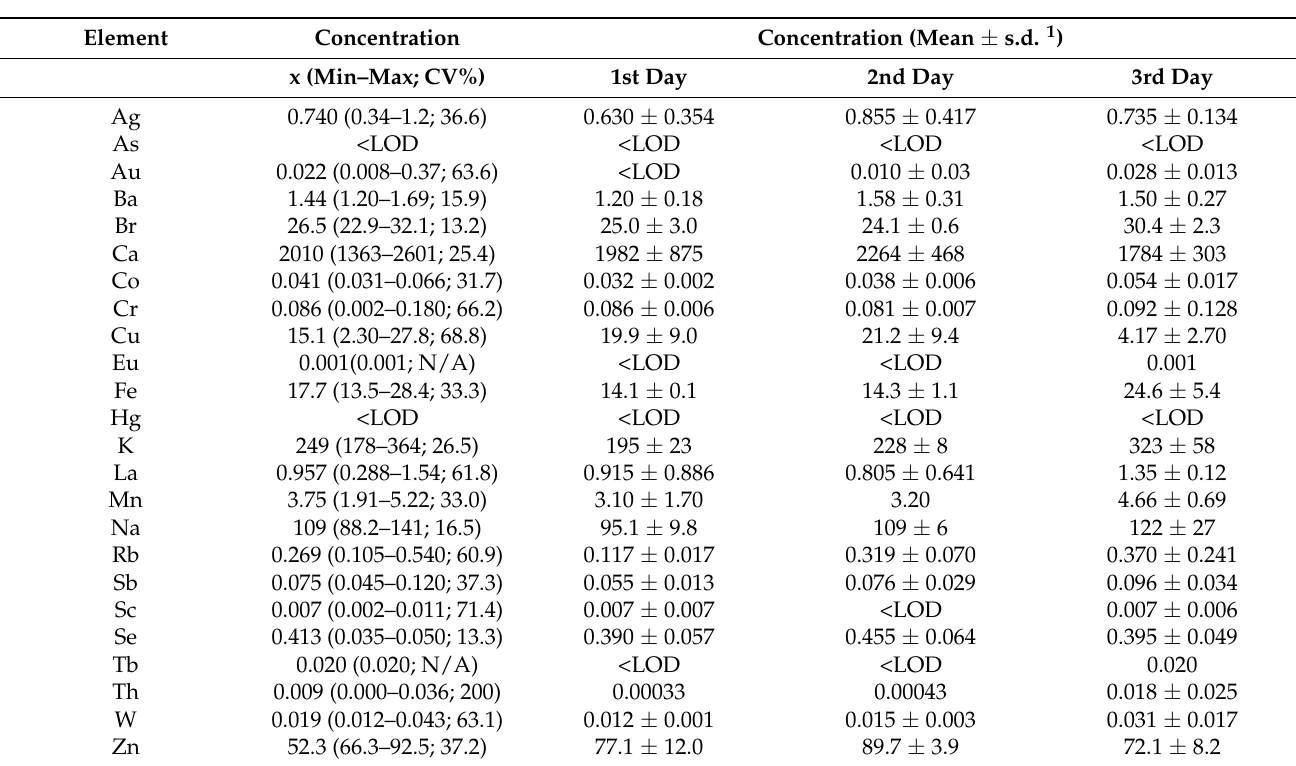
Table 2. Element levels and single daily concentrations ( µ g g − 1 ) determined in all the investigated independent samples (five independent